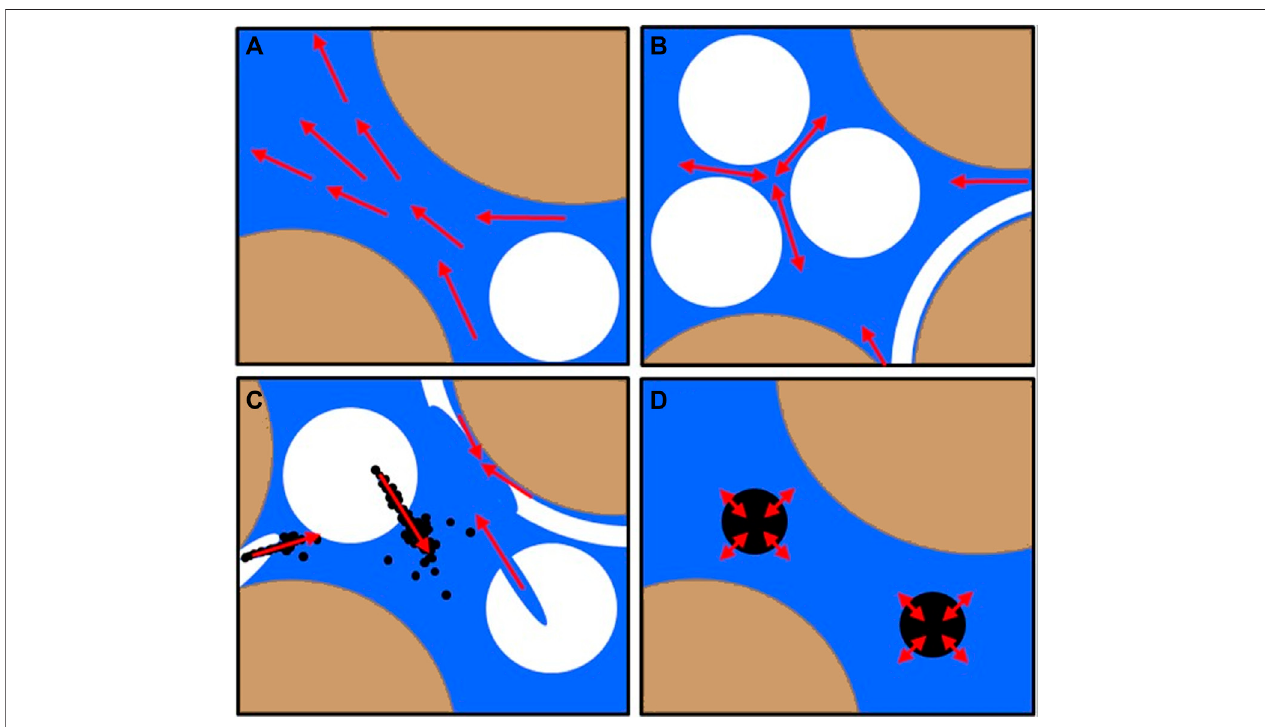
FIGURE 8 | Conceptual model (Marín-Moreno et al., 2017) to examine the effect of methane hydrate (white) and gas (black) on the geophysical properties of brine (blue)-saturated sediment(yellow). (A) Biot ’ stypeinertial fl uid fl ow, (B) microsquirt fl ow, (C) sub-micro squirt fl owduetoinclusionsofgasandwaterinhydrates,and (D) gas bubble resonance. Marín-Moreno et al.